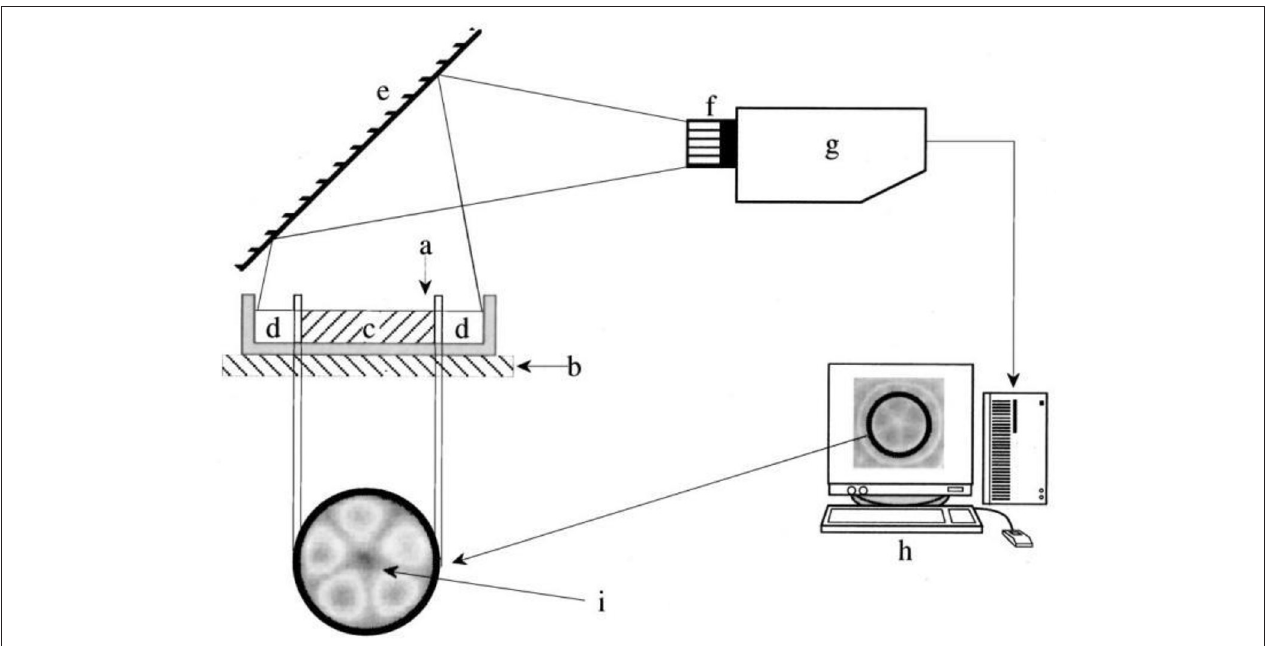
FIGURE 3 | Diagram of experimental set-up for B-M cellular flow studies: a—free surface of test liquid, b—heated plate with temperature controller, resting on analytical electro balance, c—probe liquid in Peltier dish, d—container, e—inclined aluminum mirror, f—long-focus lens, g—IR camera (infrared light range, 3–5 µ m